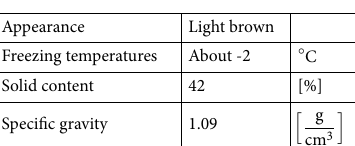
Figure 3. Fine and coarse aggregate grading curves.